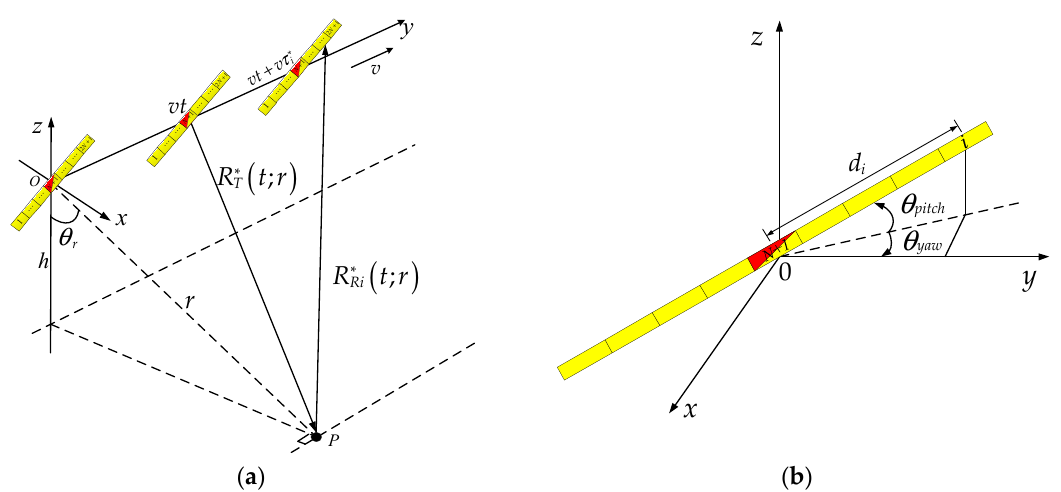
Figure 1. Geometric model of the multiple hydrophone SAS. ( a ) The acoustic propagation path; ( b ) The inclined array of hydrophones.